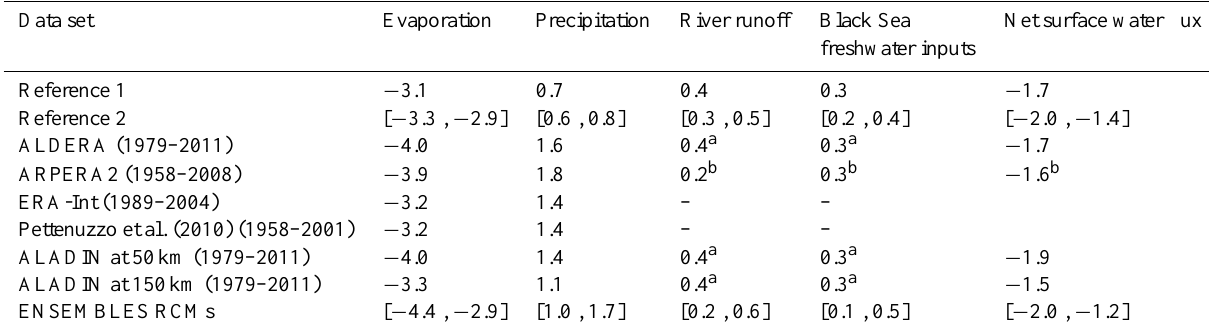
Table 2. Same as Table 1 but for the Mediterranean Sea surface water budget terms (mmday − 1 ). The reference 1 comes from Sanchez-Gomez et al. (2011) and the reference 2 from Dubois et al. (2010). The reference values do not always cover a common